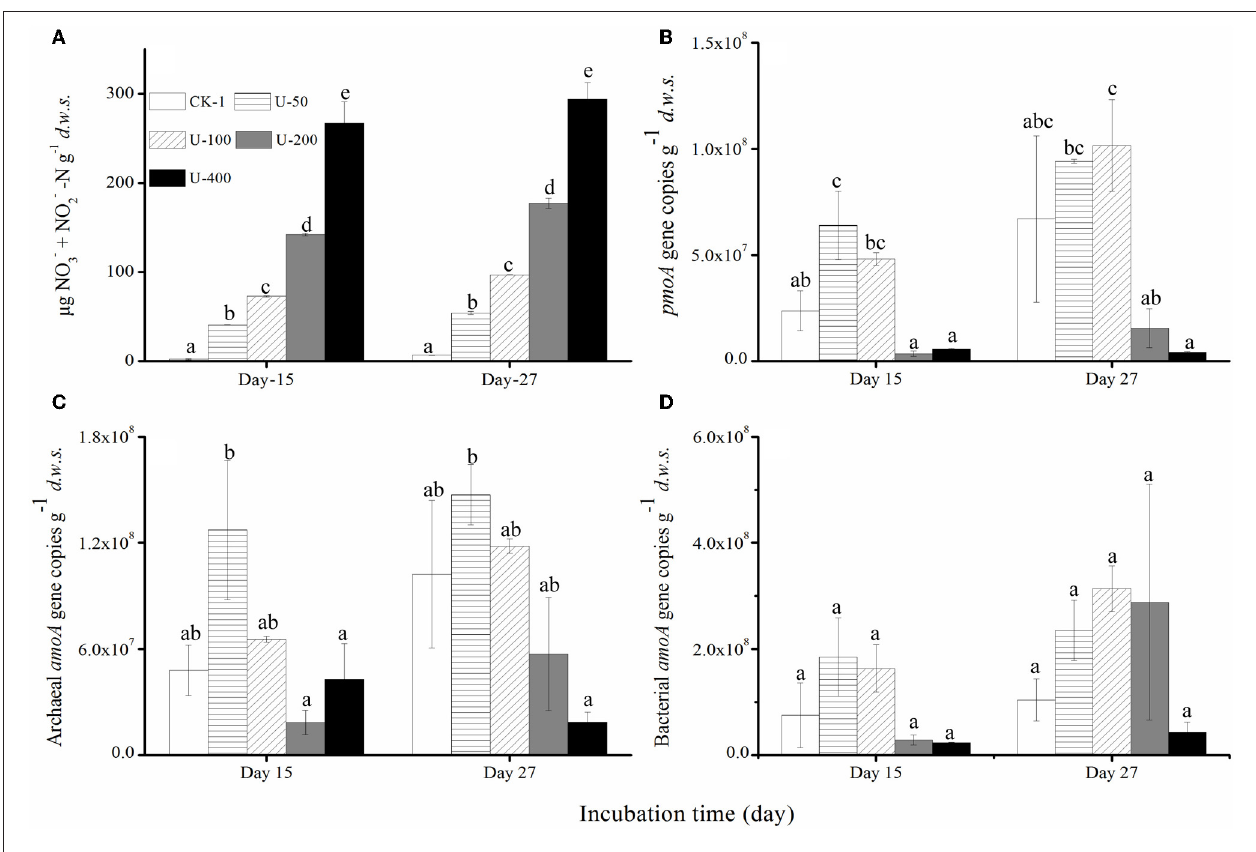
FIGURE 2 | Changes in the concentrations of NO − 3 and NO − 3 -N (A) the abundances of the pmoA genes of the methane-oxidizing bacteria (B) and the amoA genes of the Archaea (C) and Bacteria (D) in the soil microcosms amended with urea. The designations